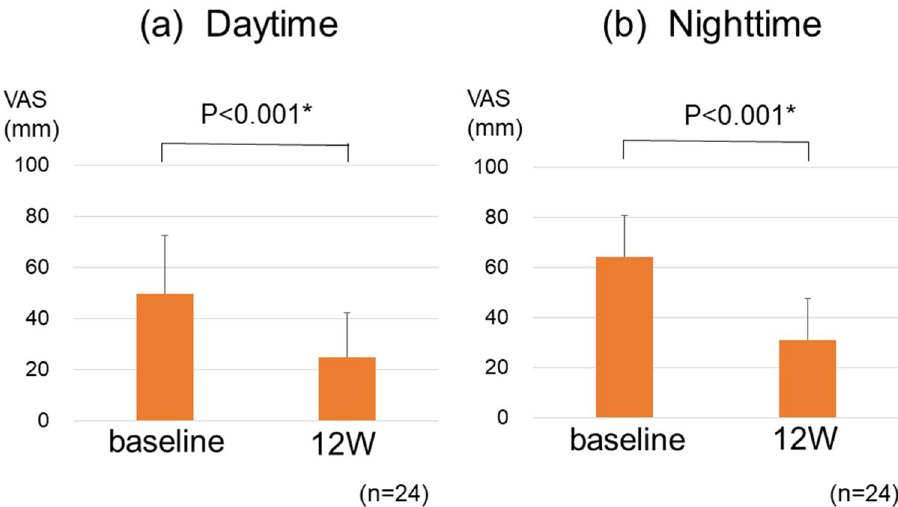
Figure 2. ( a ) Visual Analog Scale (VAS) scores significantly decreased 12 weeks after administration of nalfurafine when compared with baseline scores during daytime. The average VAS score improved from 50 to 25 mm ( P < 0.001). ( b ) VAS scores significantly decreased 12 weeks after administration of nalfurafine when compared with baseline scores during nighttime. The average VAS score improved from 64 to 31 mm ( P < 0.001). The error bars represent standard errors.